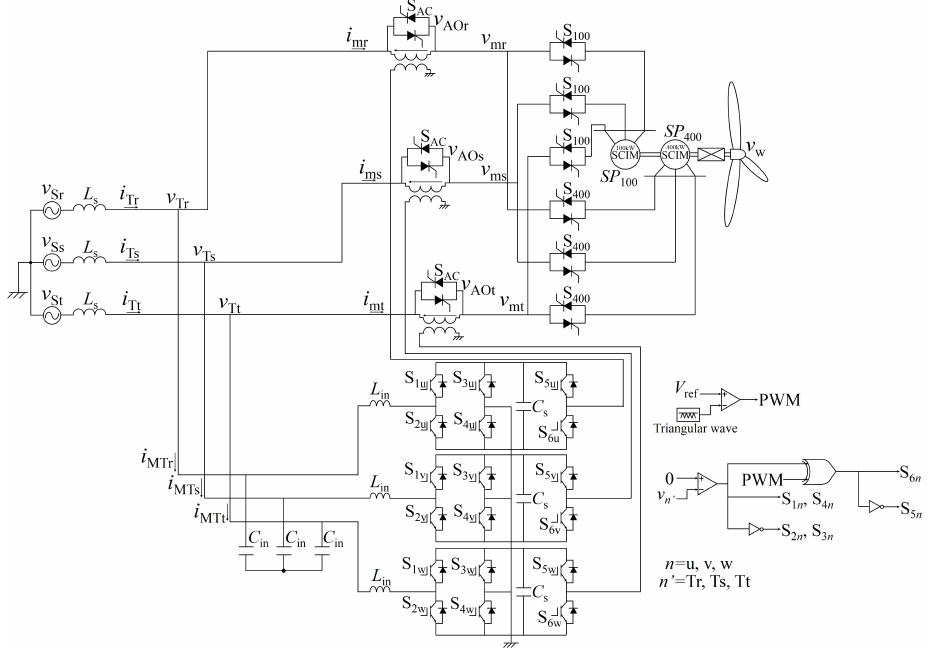
Figure 1. System configuration with the proposed inrush current suppressor using the AC chopper in a large-capacity wind power generation system